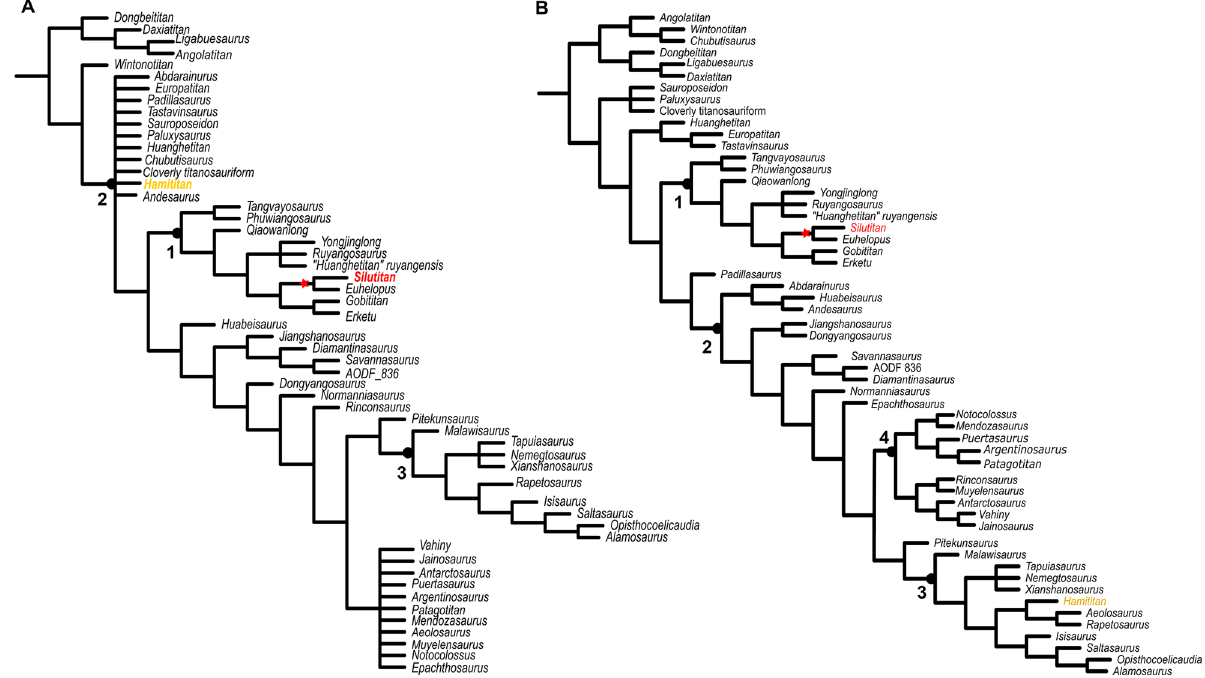
Figure 8. Strict consensus cladogram based on Mannion et al. dataset 54 with Silutitan sinensis and Hamititan xinjiangensis scored as two separated taxa: ( A ) applying equal weighting and ( B ) applying extended implied weighting, with k-value 9. Nodes numbers indicate the clades retrieved: 1. Euhelopodidae, 2. Titanosauria, 3. Lithostrotia, and 4. Colossosauria. Silutitan sinensis is highlighted in red and Hamititan xinjiangensis , in